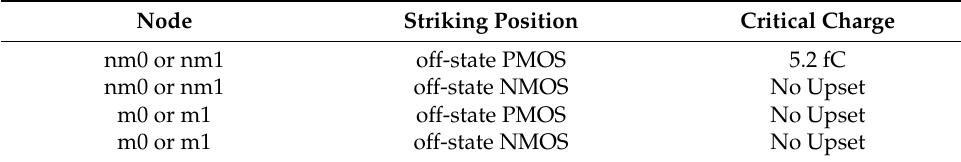
Table 2. Critical Charge of the Sensitive Nodes in the Master Latch of the